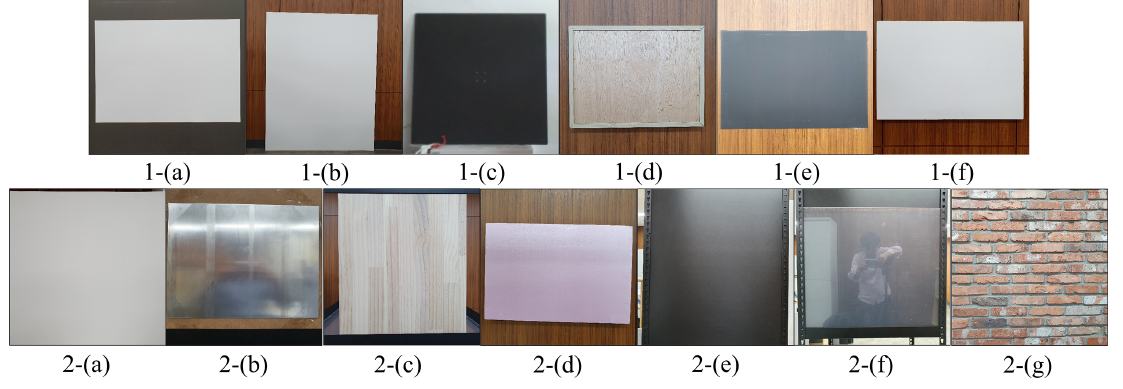
Figure 5. First experiment material: 1-( a ) coated paper, 1-( b ) canvas paper for oil painting, 1-( c ) iron plate, 1-( d ) MDF in which small wood particles were united, 1-( e ) acrylic (thickness 2 mm), and 1-( f ) styrofoam board (thickness 5 mm). Second experiment material: 2-( a ) canvas paper for oil painting, 2-( b ) aluminum (thickness 2 mm), 2-( c ) radiata pine wood, 2-( d ) styrofoam board used as a hot insulating material (thickness 30 mm), 2-( e ) pomex: PVC foam sheet (thickness 2 mm), 2-( f ) transparent acrylic (thickness 5 mm), and 2-( g ) red